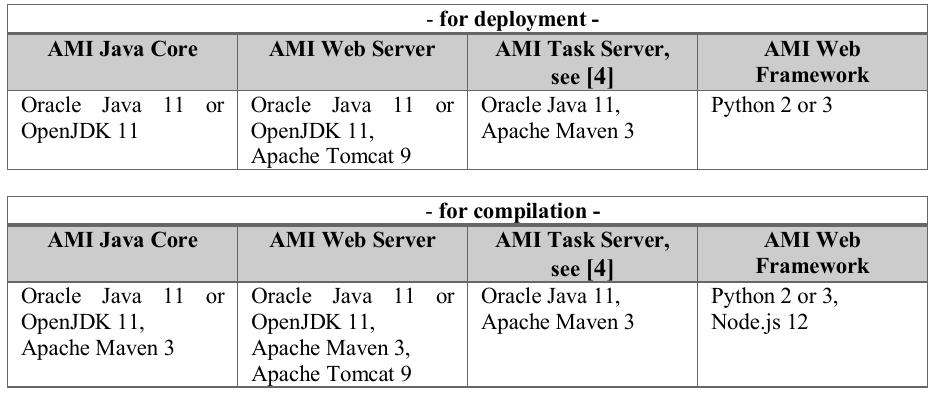
Table 1. Minimum software requirements for both deployment and compilation from sources.